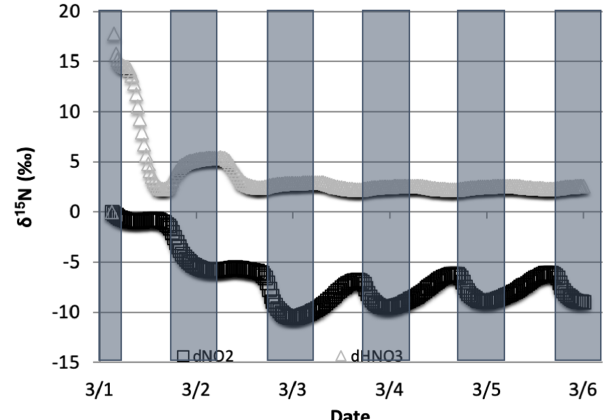
Figure 13. The difference in δ 15 N values of NO 2 and HNO 3 when the isotopic effect during N 2 O 5 heterogeneous reactions (Reac- = 1 . 029) and when it is tions R53–R54, R239) is included ( α N 2 O 5 = 1 . 0). The 5d simulation was under the condi- excluded ( α N 2 O 5 tions list in Table